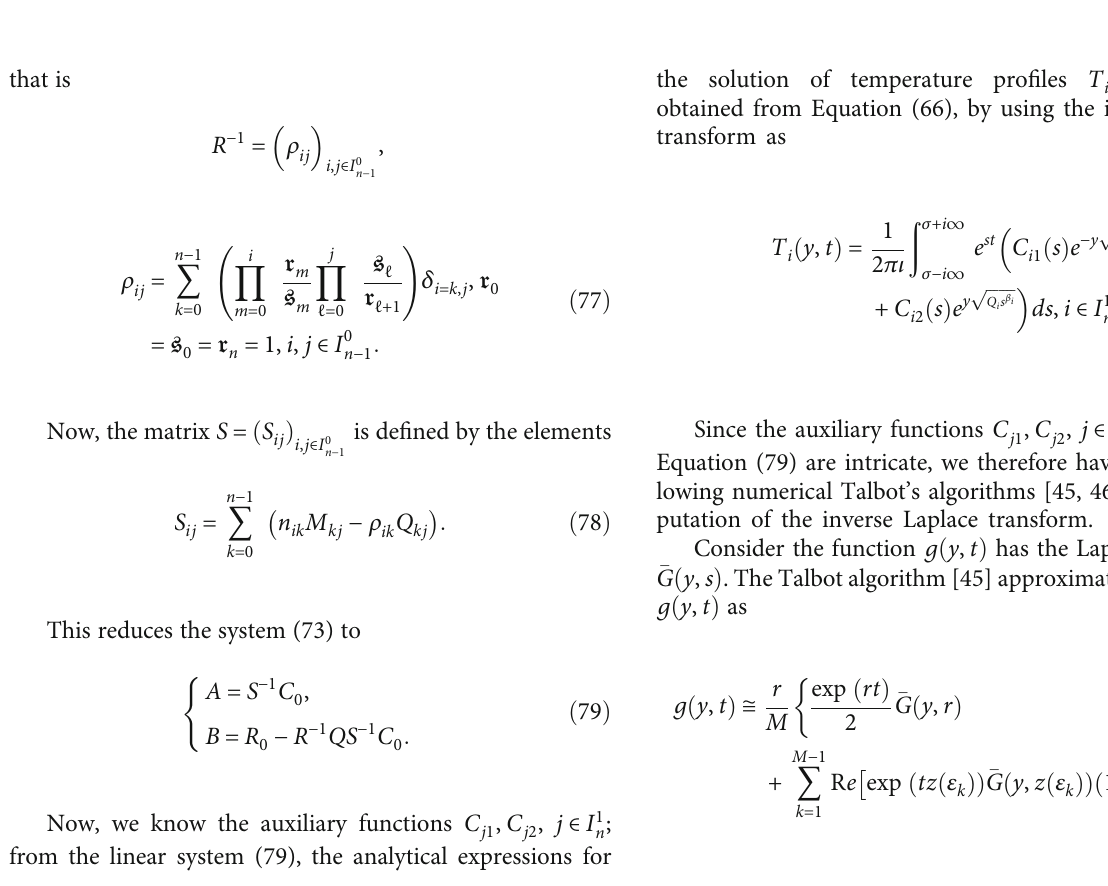
= 0 : 2 , β = 0 : 4, and di ff erent 1 2